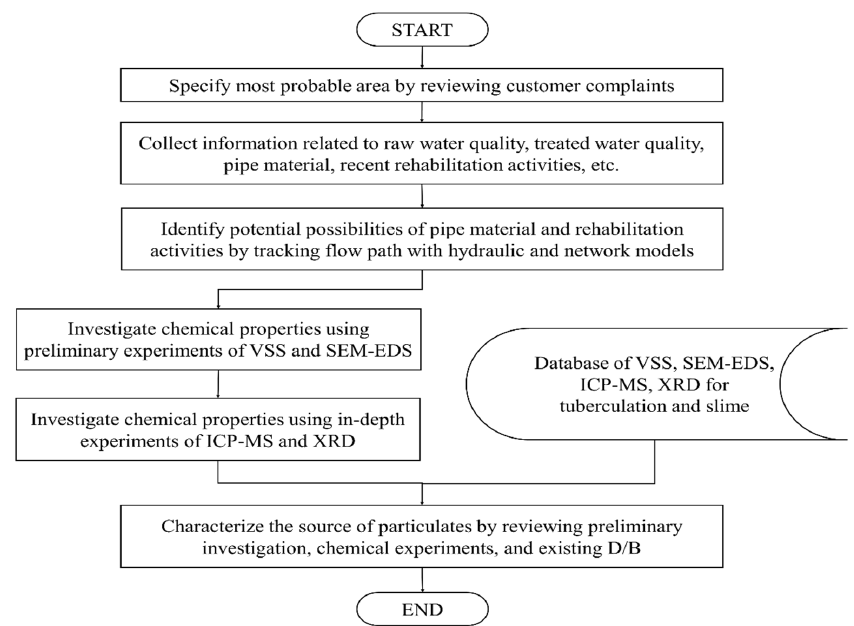
Figure 1. Procedure for characterizing the sources of particulates.